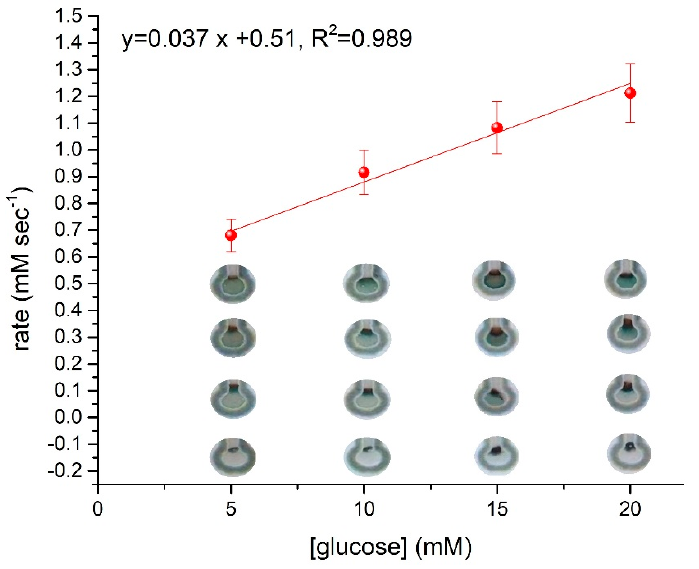
Figure 6. Kinetic plot of glucose reaction rate with o-dianisidine.